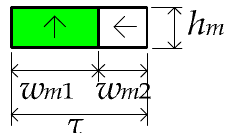
Figure 6. Selection of the permanent magnet array variable.